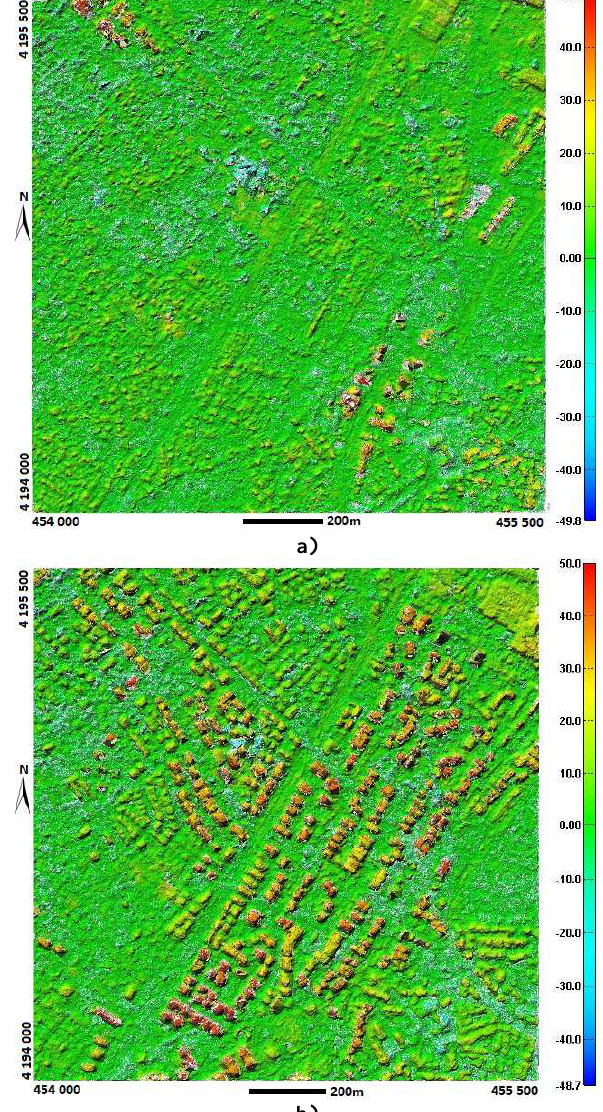
Figure 5. a) The changes between date of 1951 and 1075, b) The changes between date of 1951 to 2010. Colour legend shows height differences. Left below corner is on 37°52'38.03"N